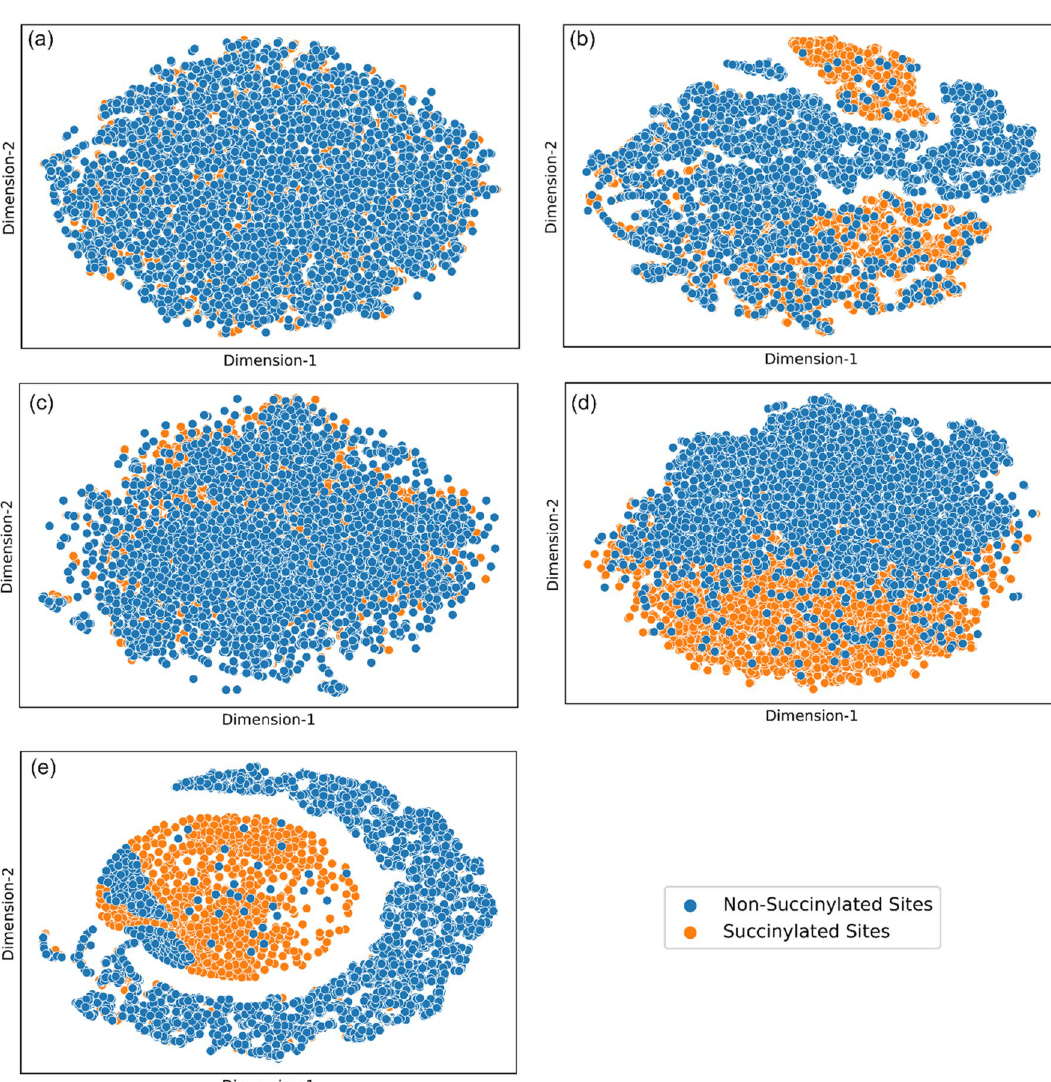
Figure 5. t-SNE to visualize the high-dimensional embedding learned by different features. ( a ) Before training CNN2D Embedding module ( b ) after training CNN2D with Embedding ( c ) before training the ANN model using prot-T5 features ( d ) after training the ANN model using prot-T5 features ( e ) after training the combined model. Blue dots represent non-succinylated sites and orange dots represent succinylated